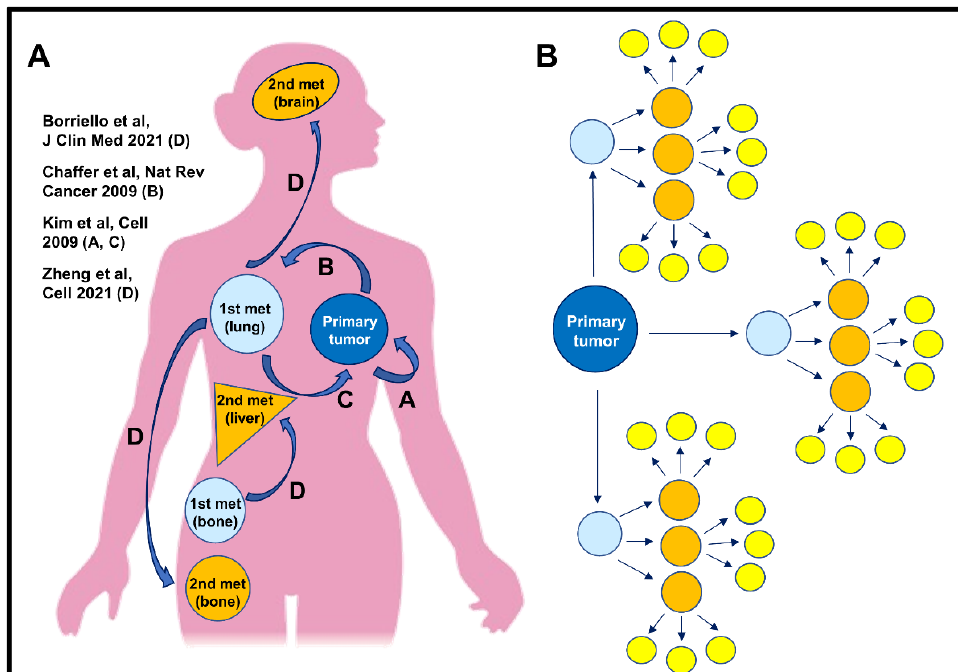
Figure 2. The roads of metastasis. ( A ) Cartoon representing multi-directional pathways of metastasis formation. Pathway A. Cancer cells can leave the primary tumor, circulate, and eventually return to its origin, i.e., primary tumor [10]. Pathway B. Cancer cells can leave the primary tumor and extravasate at the secondary site (e.g., lungs) where they form metastatic foci [4,5]. Pathway C. From a metastatic focus, cancer cells can also re-intravasate and re-seed back to the primary tumor (if still in place), or travel and seed tertiary metastatic sites, Pathway D [12–14,39], enhancing metastatic burden. ( B ) Schematic representation showing that cancer cell re-dissemination from metastatic foci drastically enhances metastatic burden, which may contribute to cancer patient mortality. Primary tumor that, according to the classic concept of metastasis, produce only three metastatic foci (light blue circles), could, after only two rounds or re-dissemination originating from these three metastatic foci, result in 27 new metastatic foci (yellow circles), provided that the dissemination rate is constant. Thus, cancer cell re-dissemination from metastatic foci may be a new mechanism of enhancing metastatic burden.